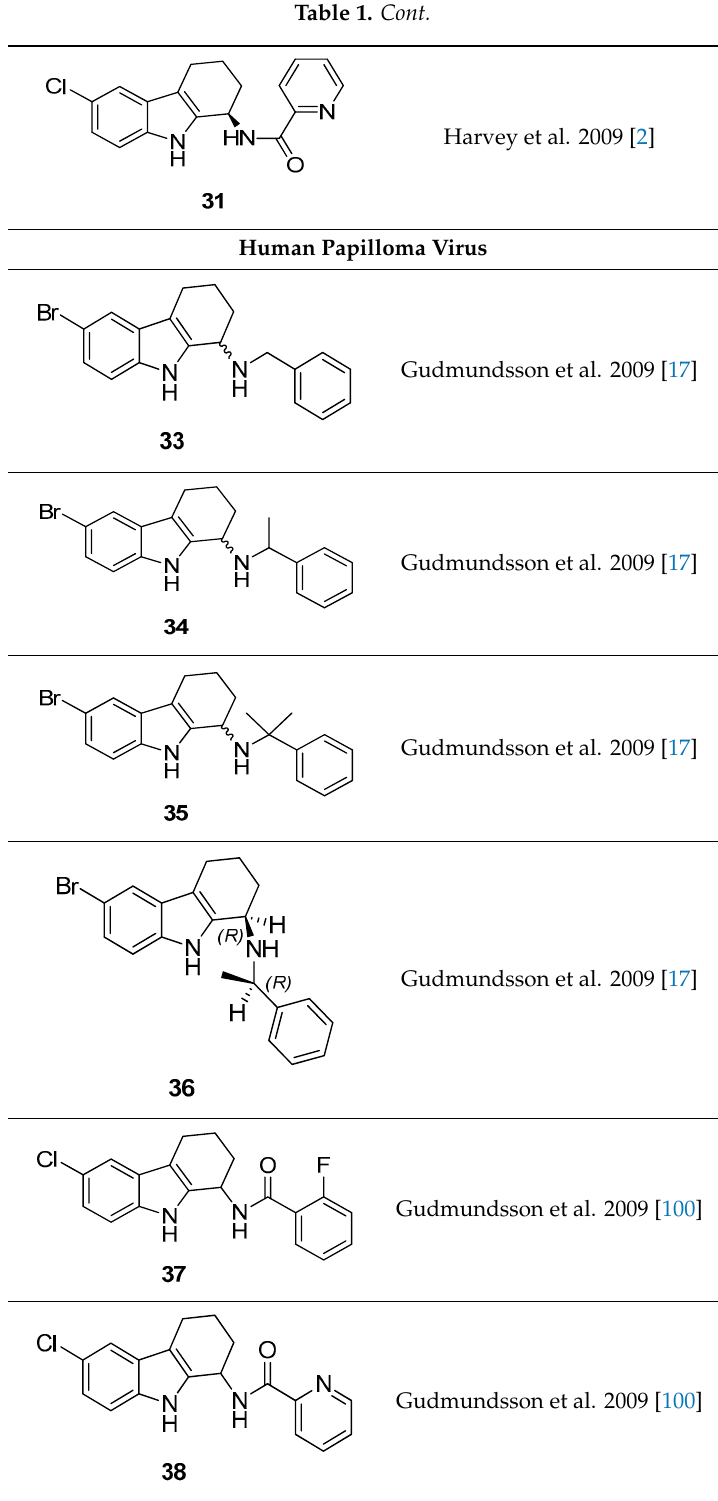
Molecules 2019 , 24 ,